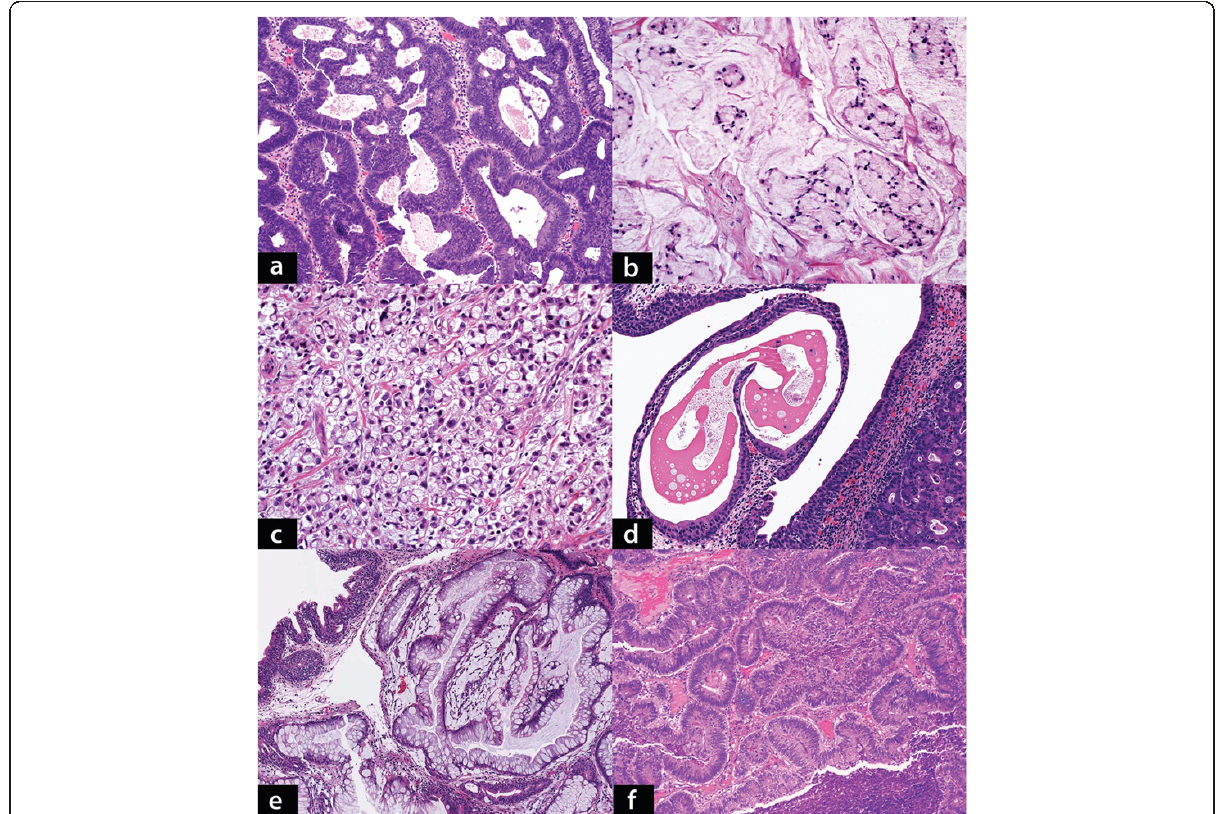
Figure 1 a: Primary bladder adenocarcinoma , enteric type. Moderately differentiated malignant glands are seen with dirty luminal necrosis. Elongated, enlarged and hyperchromatic nuclei with prominent stratification line the malignant glands. (Hematoxylin & eosin, x100). b : Primary bladder adenocarcinoma, mucinous type. Scattered small groups of tumor cells with intracytoplasmic mucin are seen in a background of abundant mucinous material (Hematoxylin & eosin, x200). c : Primary bladder adenocarcinoma, signet ring cell type: Tumor comprised of diffuse sheets of signet ring cells infiltrating the bladder wall (Hematoxylin & eosin, x200). d : Cystitis cystica involving the surface urothelium with underlying invasive primary bladder adenocarcinoma (Hematoxylin & eosin, x100). e : Extensive cystitis glandularis, intestinal type seen adjacent to a focus of invasive primary bladder adenocarcinoma (not seen in this image) (Hematoxylin & eosin, x40). f : Metastatic colorectal adenocarcinoma. Moderately differentiated, infiltrating malignant glands with morphological features similar to primary bladder adenocarcinoma see in a (Hematoxylin & eosin,